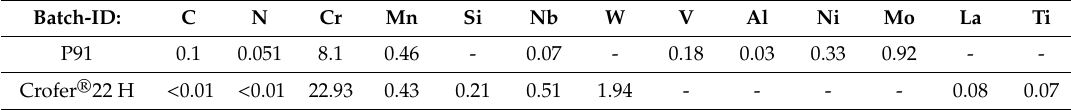
Table 1. Chemical composition (wt%) of the experimental materials.